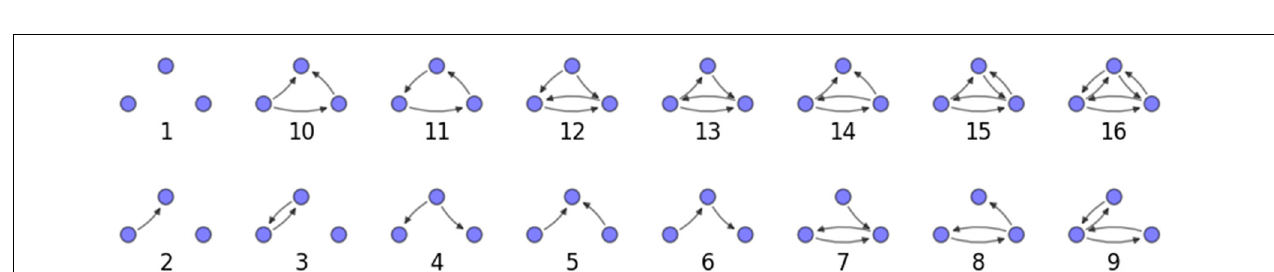
FIGURE 7 | Triadic motif key.